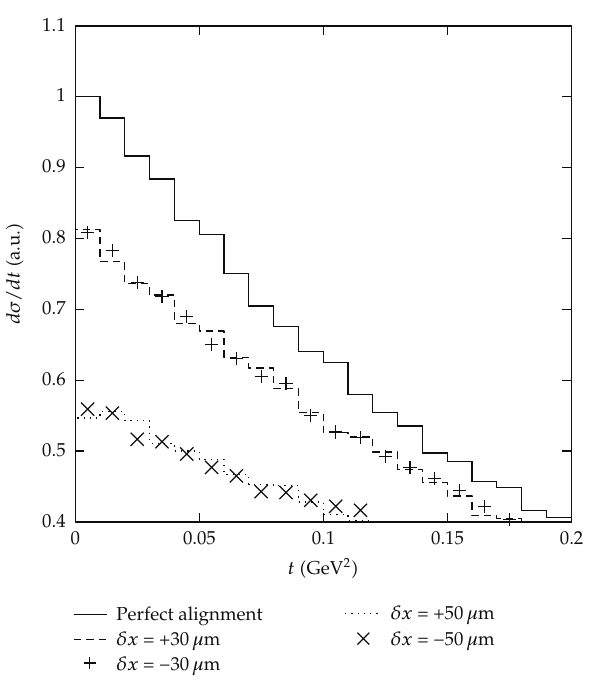
Figure 1: Reconstructed four-momentum distribution for di ff erent values of the relative horizontal misalignment (cid:2) δx (cid:3)